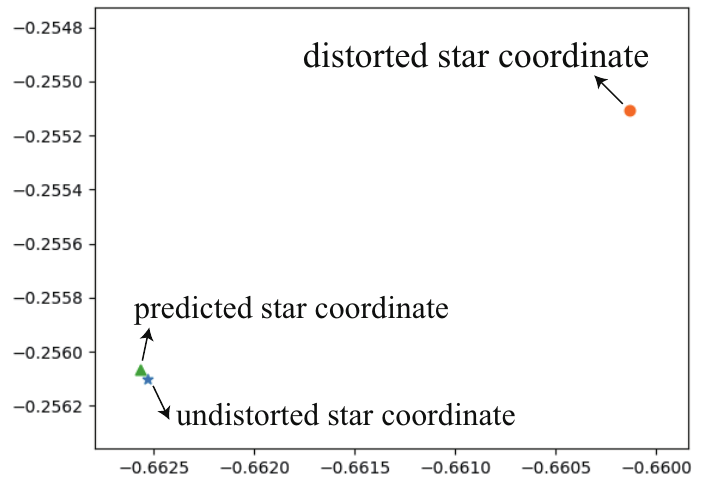
Figure 10. Star coordinates of undistorted star spot ( (cid:63) ), distorted star spot ( ◦ ) and predicted star spot ( (cid:52) ). The coordinates are all normalized to [−1,